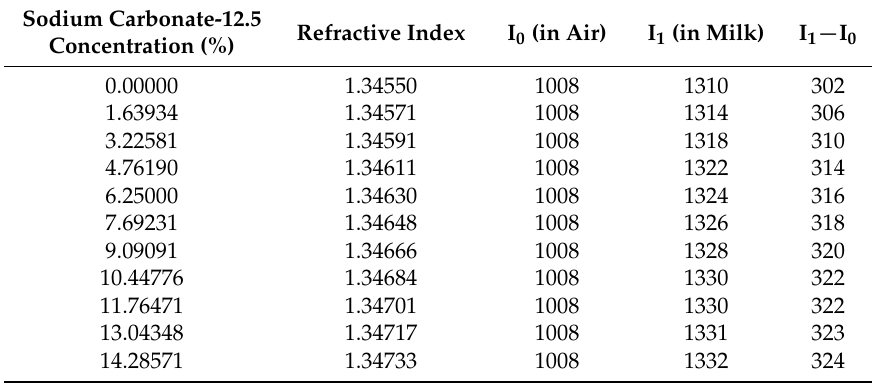
Table 4. Sensor readouts with probe P-233 for sodium